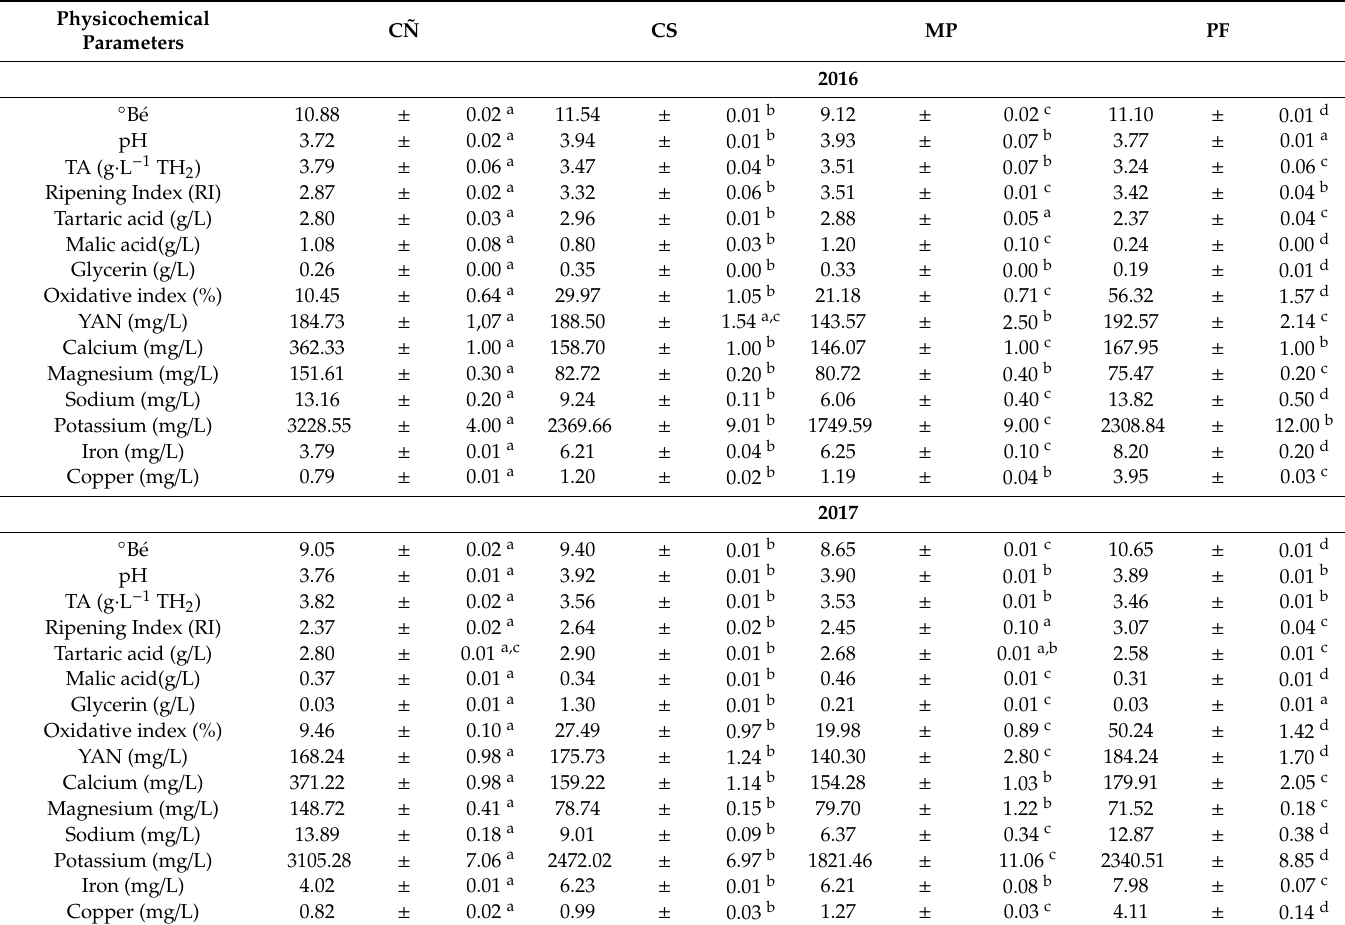
Table 3. Autochthonous varieties and Palomino Fino grape must characterization during two consecutive years (2016 and